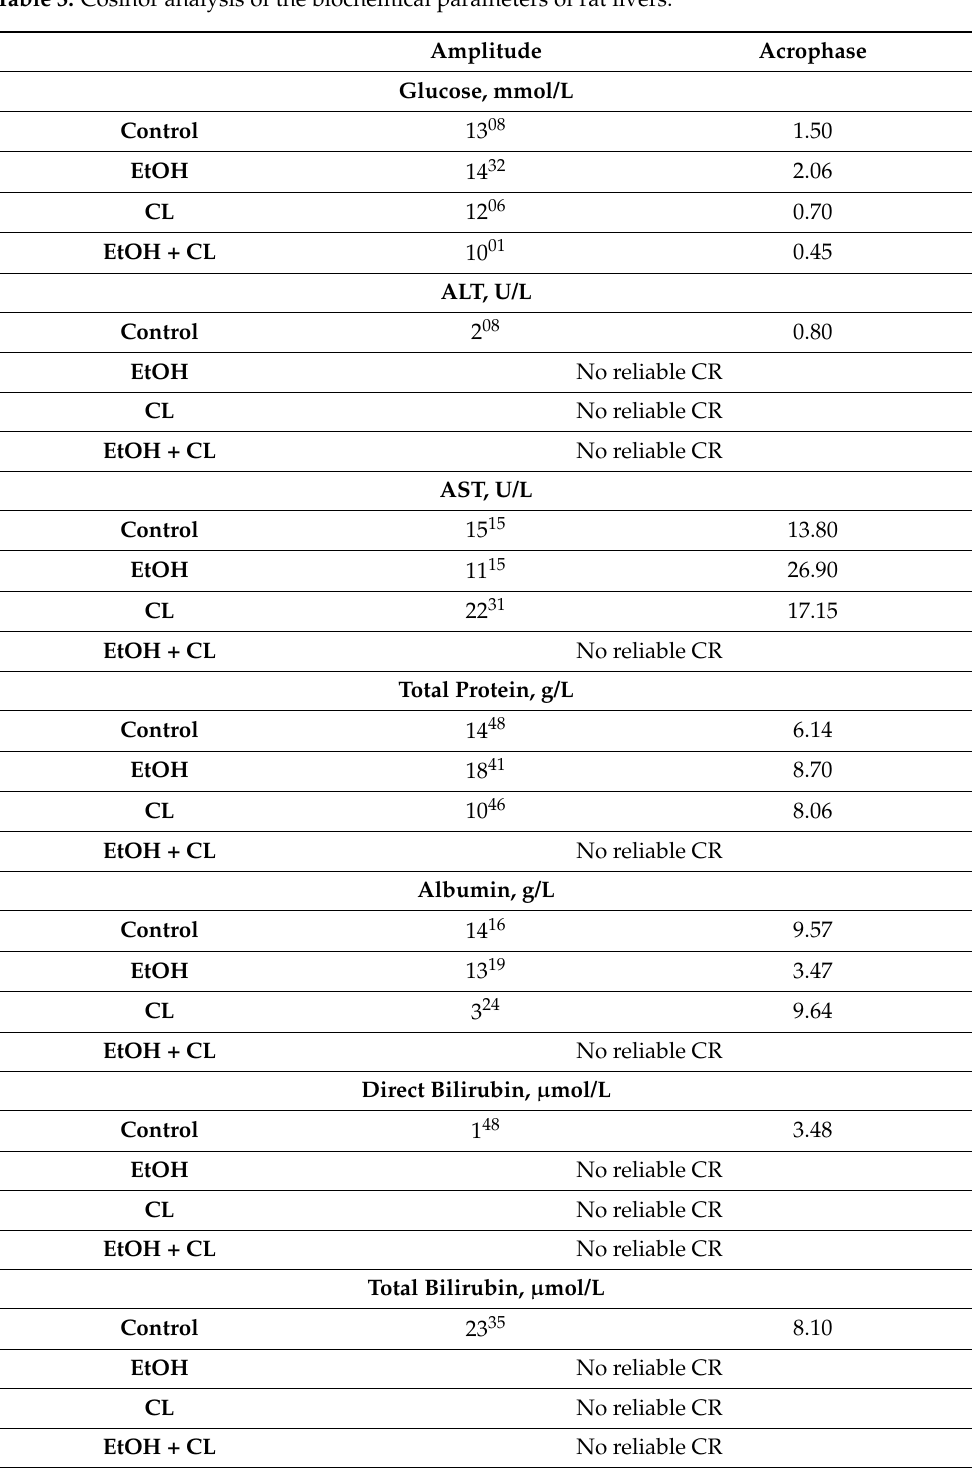
Table 3. Cosinor analysis of the biochemical parameters of rat